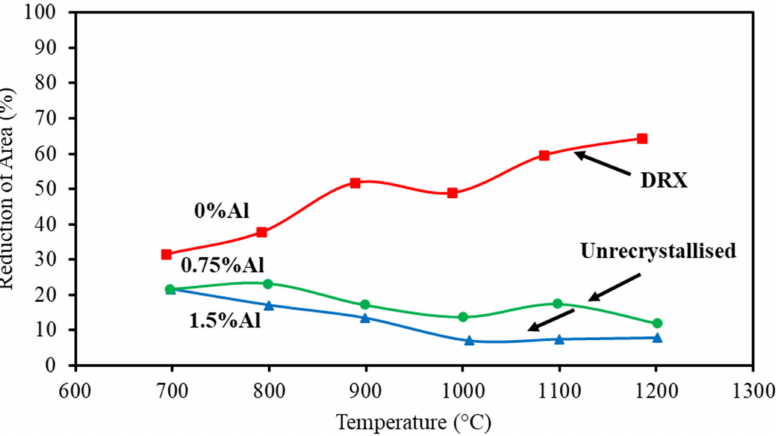
Figure 14. The hot ductility of TWIP steel at different Al content for the base composition: 0.6% C, 0.008% S, 18% Mn and 0.01% N [32]. The top curve is for a TWIP steel free of Al and shows the big improvement in overall ductility when DRX